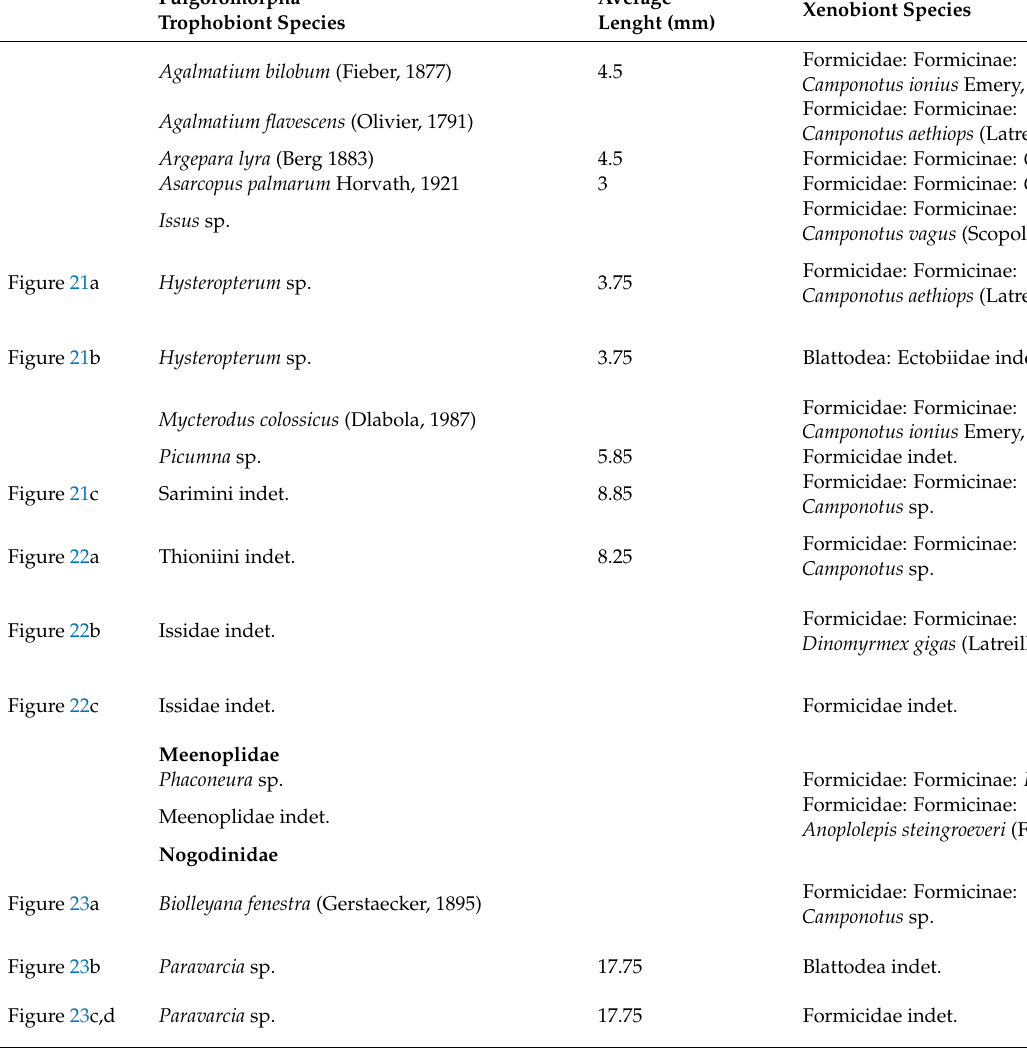
Issus sp. Figure 21a Hysteropterum sp. 3.75